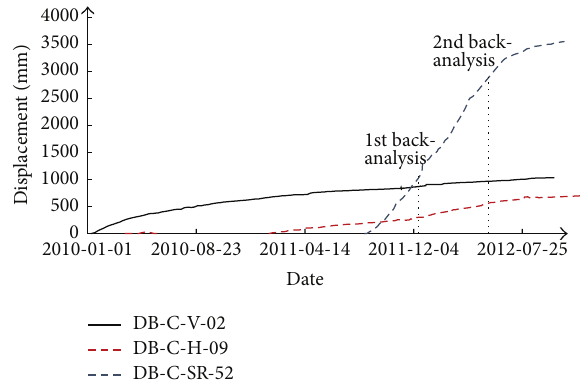
Figure 5: Measured displacements at typical observation